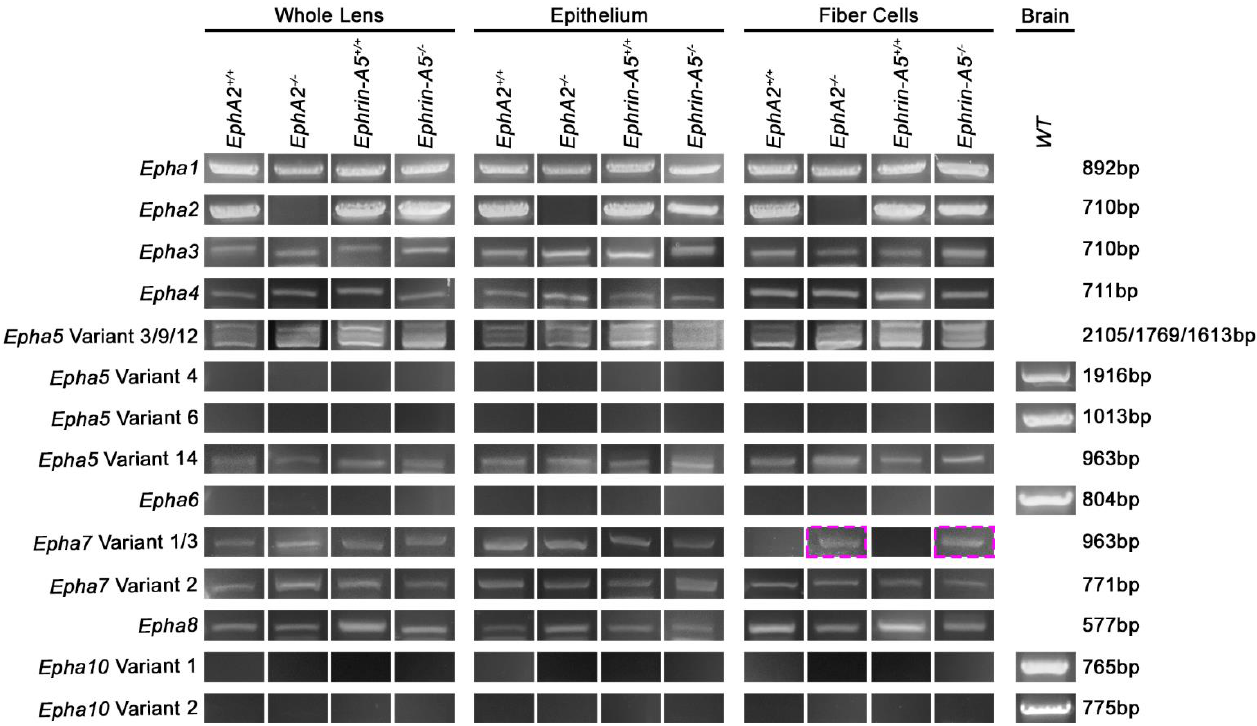
Figure 1. Epha transcripts in whole lens, lens epithelial cell, or lens fiber cell RNA samples from 6-week-old EphA2 +/+ , EphA2 − / − , ephrin-A5 +/+ , and ephrin-A5 − / − mice. Positive control was brain RNA isolated from a wild-type ( WT ) control mouse. We detected Epha1 , Epha2 , Epha3 variant 1, Epha4 , Epha5 variants 3, 9, 12, and 14, Epha7 variants 1 and 2, and Epha8 in the lens. As expected, Epha2 was not detected in EphA2 − / − lens samples. Epha7 variant 1 was detected in all whole lens and epithelial cell samples and in the fiber cells of EphA2 − / − and ephrin-A5 − / − lenses (magenta boxes). We did not detect Epha6 or Epha10 in the lens.